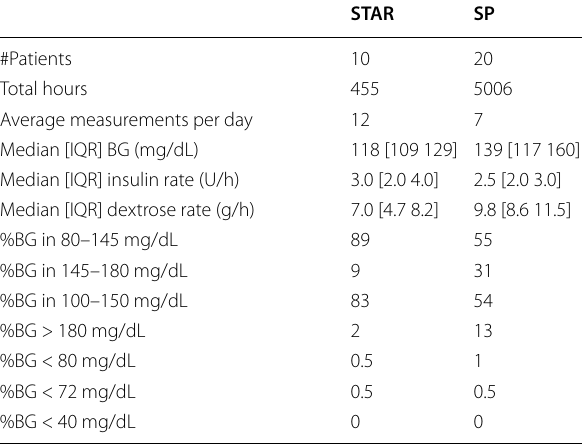
Table 1 Results summary for performance, safety and compliance to protocol comparison between STAR and the Standard Protocol